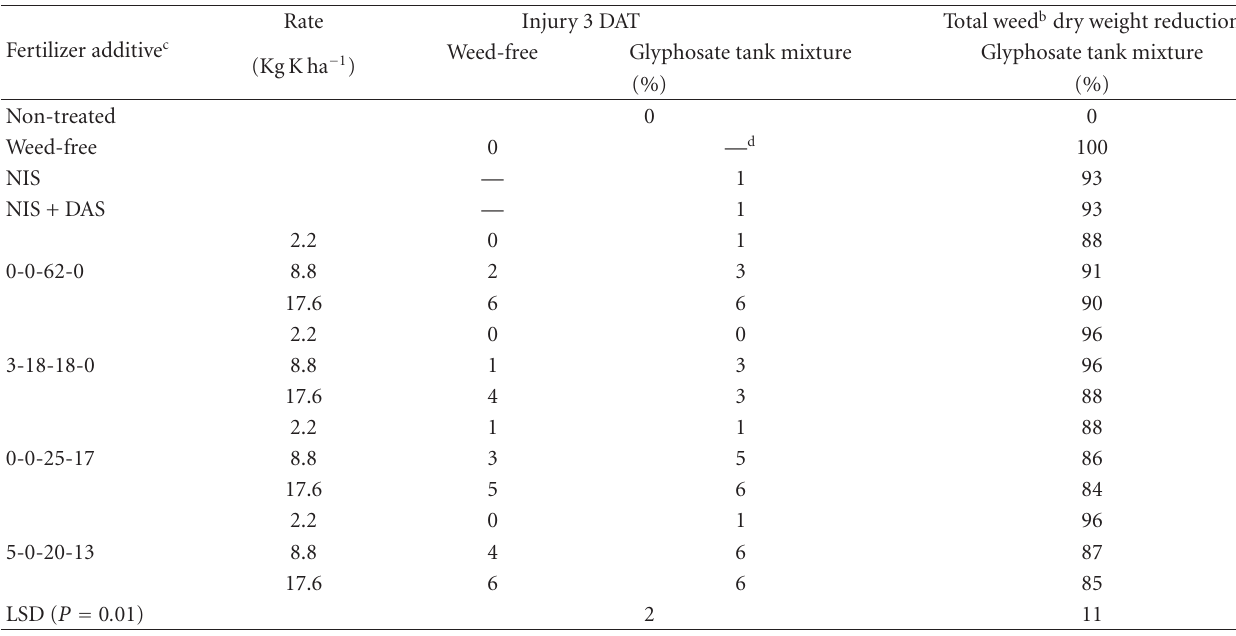
Table 3: The e ff ect of fertilizer additive on soybean injury 3d after treatment (DAT) in the presence and absence (weed-free) of glyphosate, and total weed dry weight reduction of fertilizer additives tank-mixed with glyphosate at Novelty 28 DAT in 2004 and 2005. Data were combined over years a